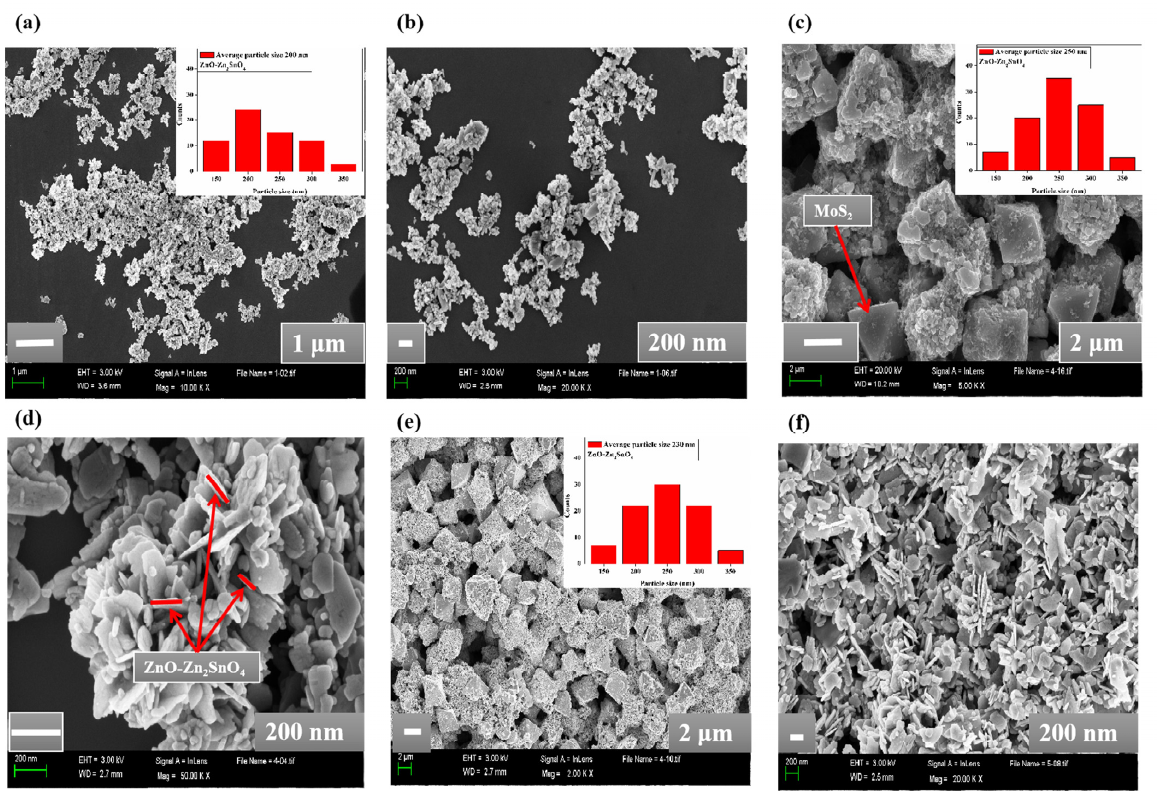
Figure 2. Morphologies of the nanocomposites: ( a , b ) SEM images of MS-ZNO-0; ( c , d ) SEM images of MS-ZNO-5; ( e , f ) SEM images of MS-ZNO-10.